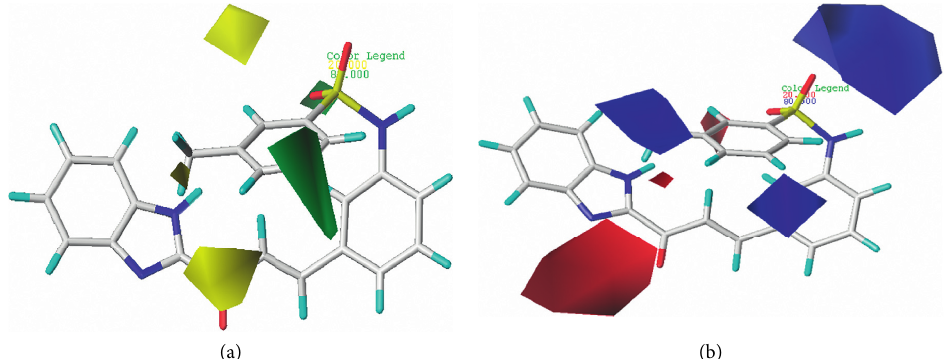
Figure 7: Steric (a) and electrostatic (b) contour maps of the CoMFA model.